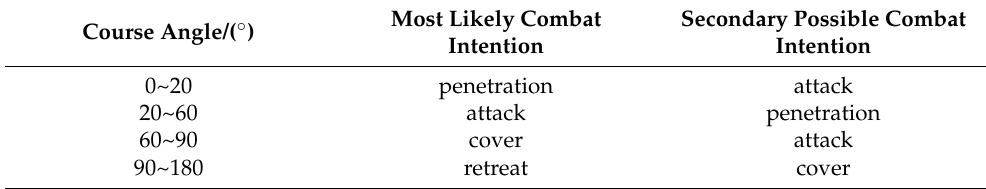
Table 2. The relationship between course and the combat intention of the target fighter.